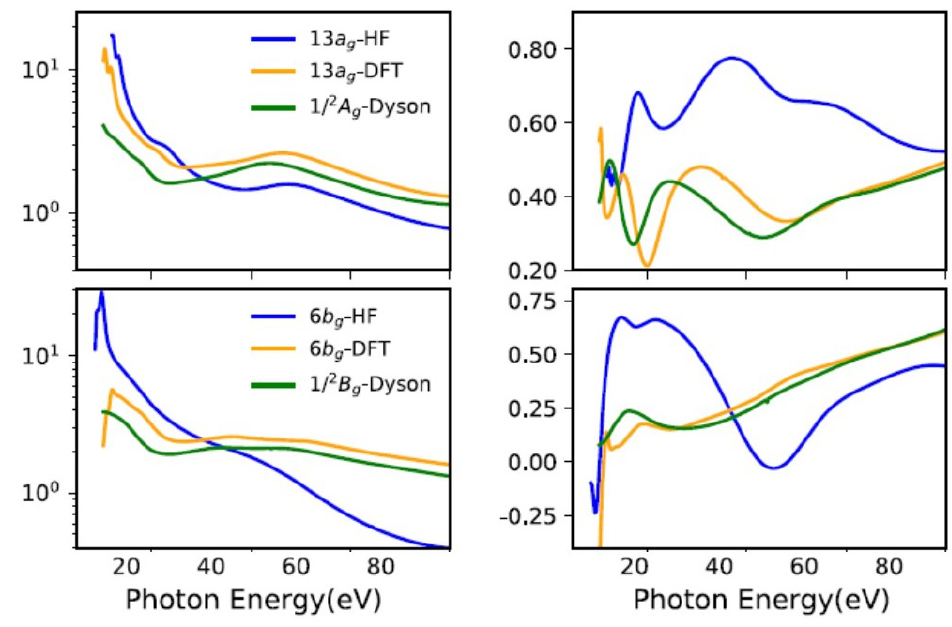
Figure 3. Nickel bis-allyl cross section and β parameter at the DFT, HF and Dyson-DFT level. From Ref. [20] with